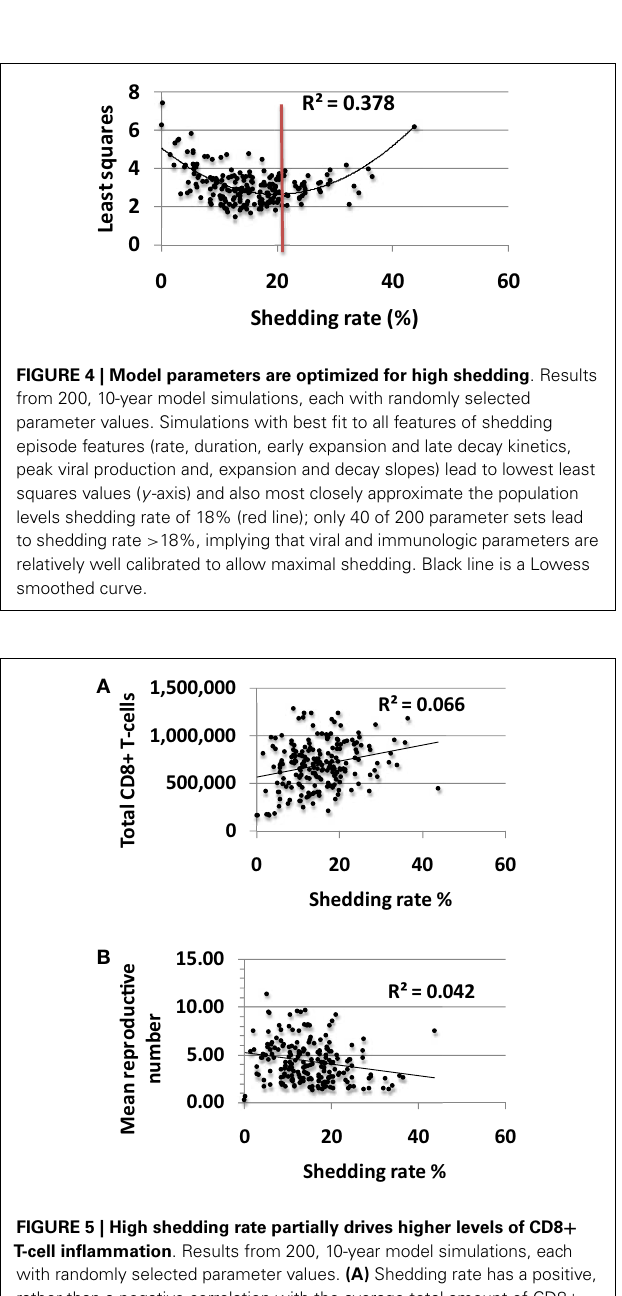
FIGURE 5 | High shedding rate partially drives higher levels of CD8 + T-cell inflammation . Results from 200, 10-year model simulations, each with randomly selected parameter values. (A) Shedding rate has a positive, rather than a negative correlation with the average total amount of CD8 + T-cells in the genital tract over a 10-year period. (B) The average growth potential (reproductive number) of all 300-model regions over 10years in high shedders, indicating that during the natural history of disease, high shedding rate actually correlates with a slightly lower average growth potential for virus across time and